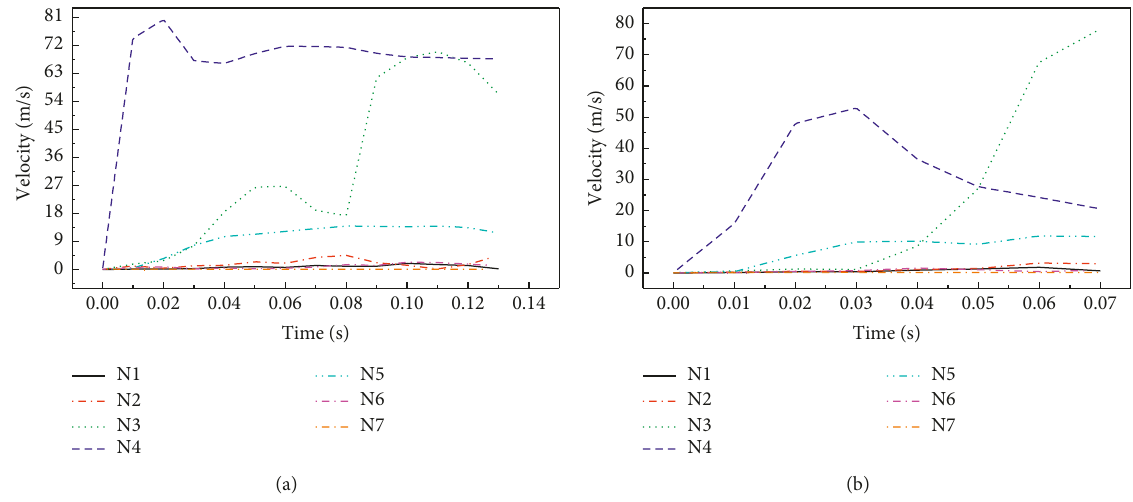
Figure 10: Velocity of ball nodes along the impact direction at 80 m/s. (a) Oblique impact. (b) Lateral